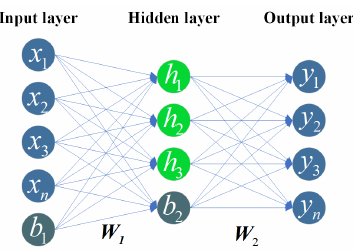
Figure 11. Typical neural network structure diagram.